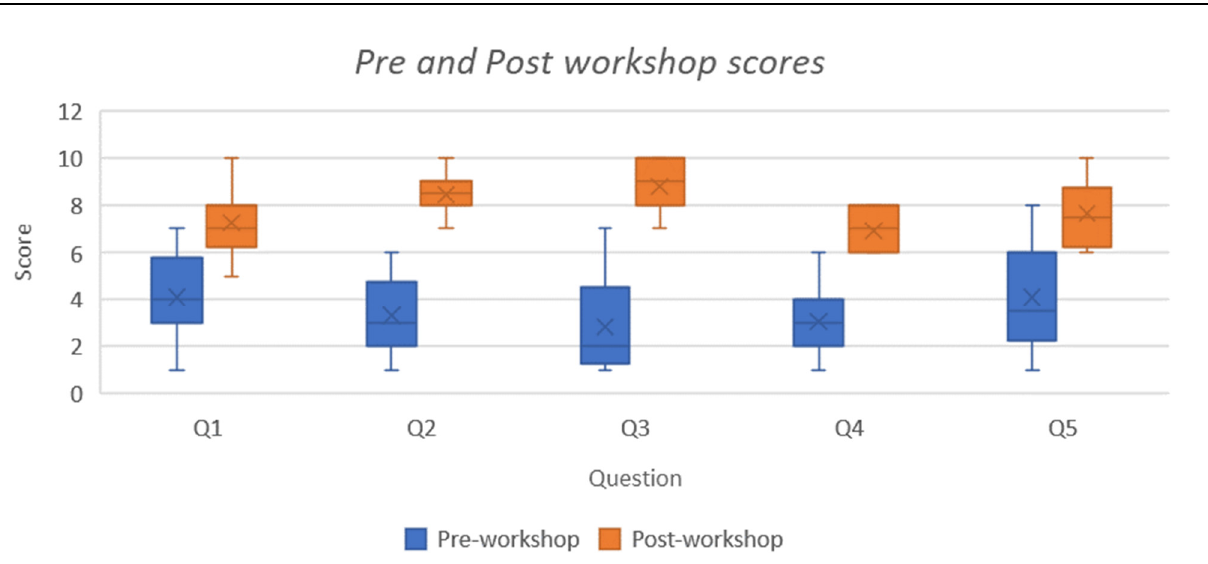
Figure 1. Pre- and Post-workshop Scores Distribution. Note: Pre and post workshop evaluation scores for the non-First Nations group.